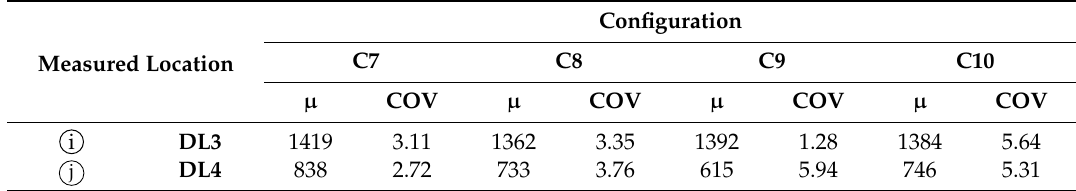
Table 2. Average electrical resistivity (ER) of concrete slab specimen 1 at di ff erent probe configurations and di ff erent measurement points for small delamination defects.